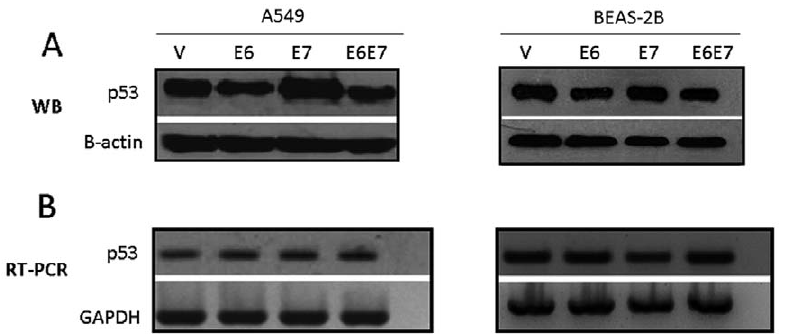
Figure 2. HPV16 E6 and E7 oncoproteins have functional activity in lung cells. A : Western blot for p53 protein in A549 and BEAS-2B transfected cells with the corresponding construct. B : Transcriptase-reverse PCR for p53 transcripts in A549 and BEAS-2B transfected